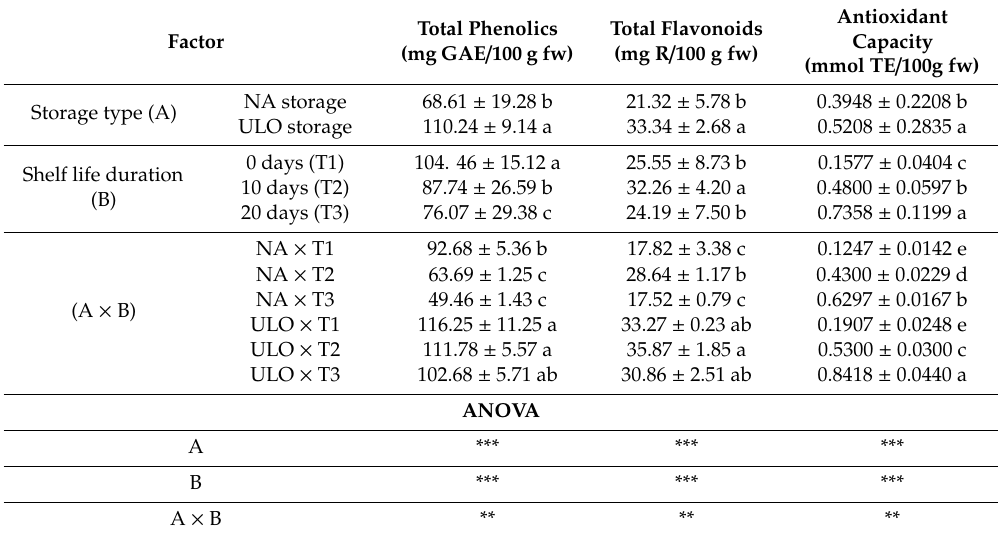
Table 1. The effect of storage type and shelf life duration on total phenolics, total flavonoids content, and antioxidant capacity in ‘Golden Delicious’ apples.